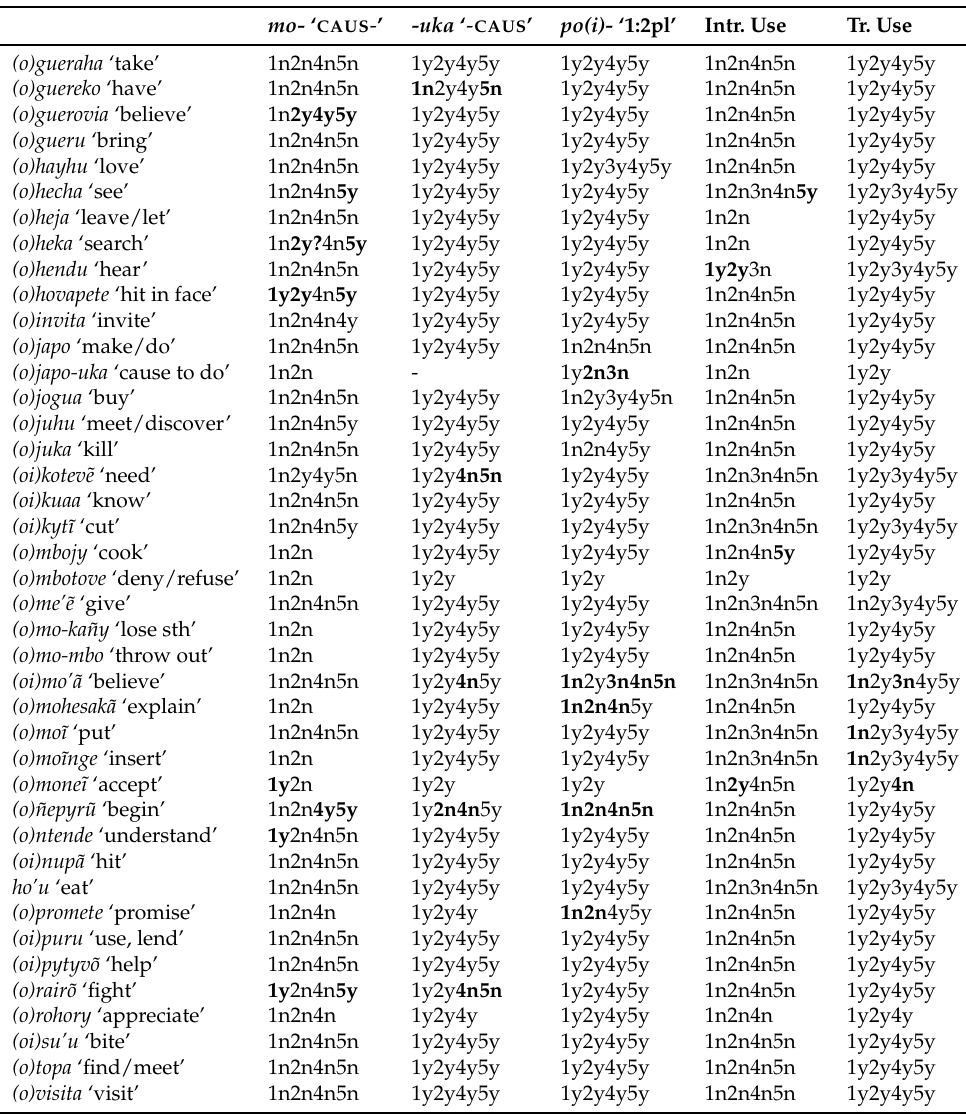
Table A1. Judgments for verbs that pattern like (di)transitive verbs. mo- ‘ CAUS - ’ -uka ‘ - CAUS ’ po(i)- ‘1:2pl’ Intr. Use Tr. Use